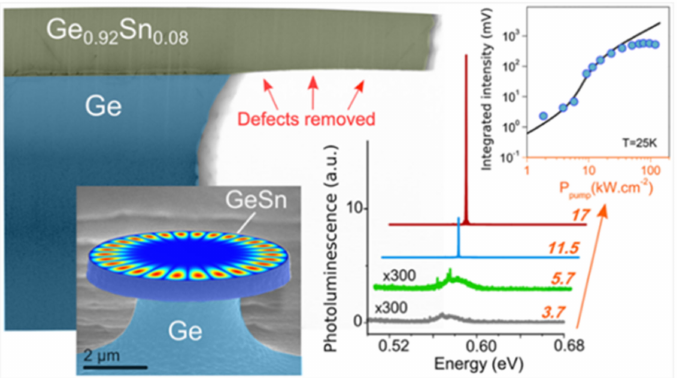
Figure 32. GeSn microdisk laser with removed defects under the disk. Reproduced with permission from [82], American Chemical Society,